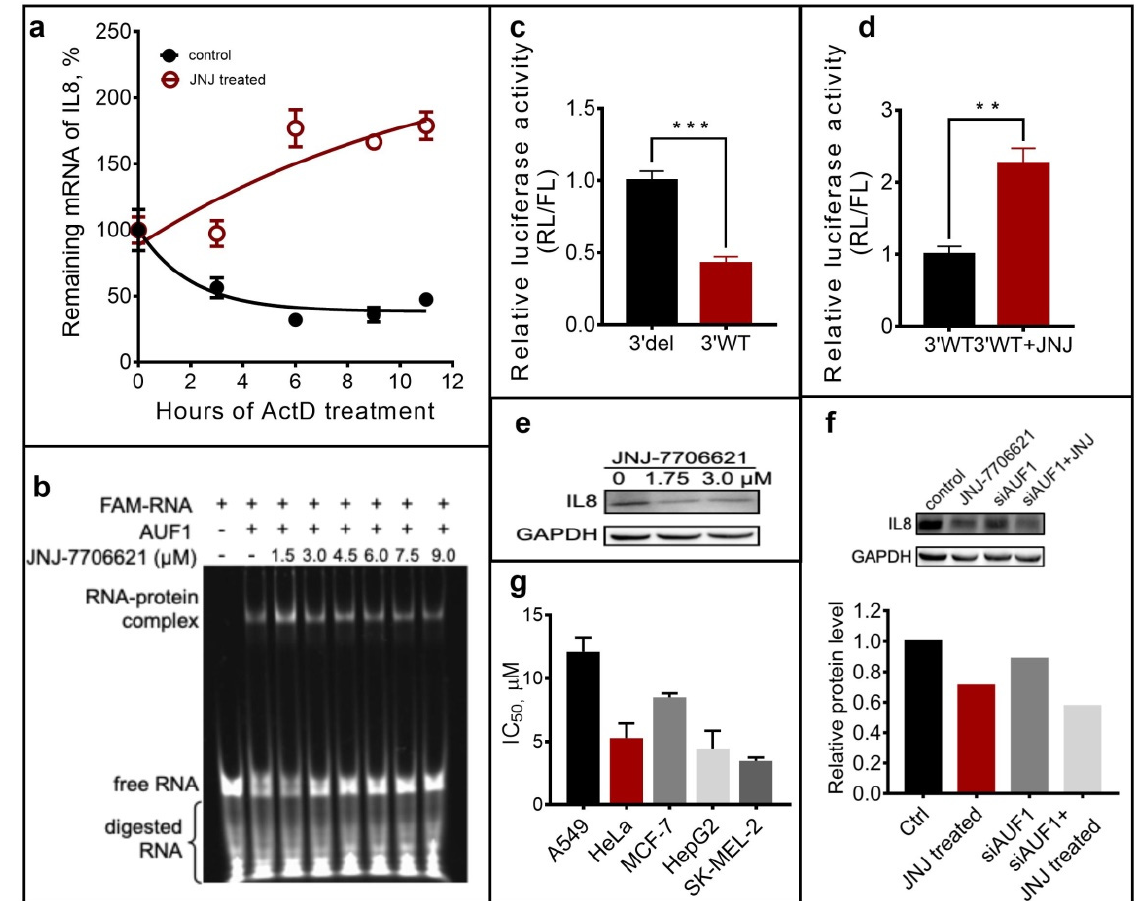
Figure 5. JNJ-7706621 regulated IL-8 gene’s translation via interacting with AUF1 and inhibited tumor cells’ proliferation. ( a ) The remaining amount of IL8 mRNA after treated with 1.75 µ M JNJ- 7706621 for 24 h in SK-MEL-2 cells. Actinomycin D (5 µ g/mL) was added to stop the transcription to detect remaining IL8 mRNA with qRT-PCR. The fitting curve was performed using GraphPad Prism. ( b ) The REMSA result of AUF1 (750 nM) incubated with the FAM-labelled RNA at 250 nM in the presence of JNJ-7706621. The sample was incubated in an incubation buffer (10 mM Tris-HCl, pH 8.0, containing 50 mM KCl, 2 mM DTT, 0.5 mM EDTA, and 0.1 μ g/ μ L BSA) and loaded on a 6% native polyacrylamide gel. ( c ) The wild-type plasmid (3 ′ WT) and mutant plasmid (3 ′ del) were trans- fected in SK-MEL-2 cells. After incubation, the relative luciferase activity (RL/FL) was detected and normalized with the data of 3 ′ del. ( d ) The relative luciferase activity of 3 ′ WT and 3 ′ WT dual-lucif- erase reporters after treated with JNJ-7706621 (1.75 μ M), normalizing with the data of 3 ′ WT. ( e ) The expression of IL8 in SK-MEL-2 cells treated with 1.75 and 3 μ M JNJ-7706621. ( f ) The expression of IL8 in SK-MEL-2 cells treated with 80 nM siRNA of AUF1. JNJ-7706621 was added after 10-h pre- incubation with the siRNA. ( g ) Inhibitory effect of JNJ-7706621 in different cancer cells for 48 h in the MTT assay. All experiments were parallelly repeated in triplicate, and data are shown as means ± SEM of n = 3. ** p < 0.01, **** p < 0.001.